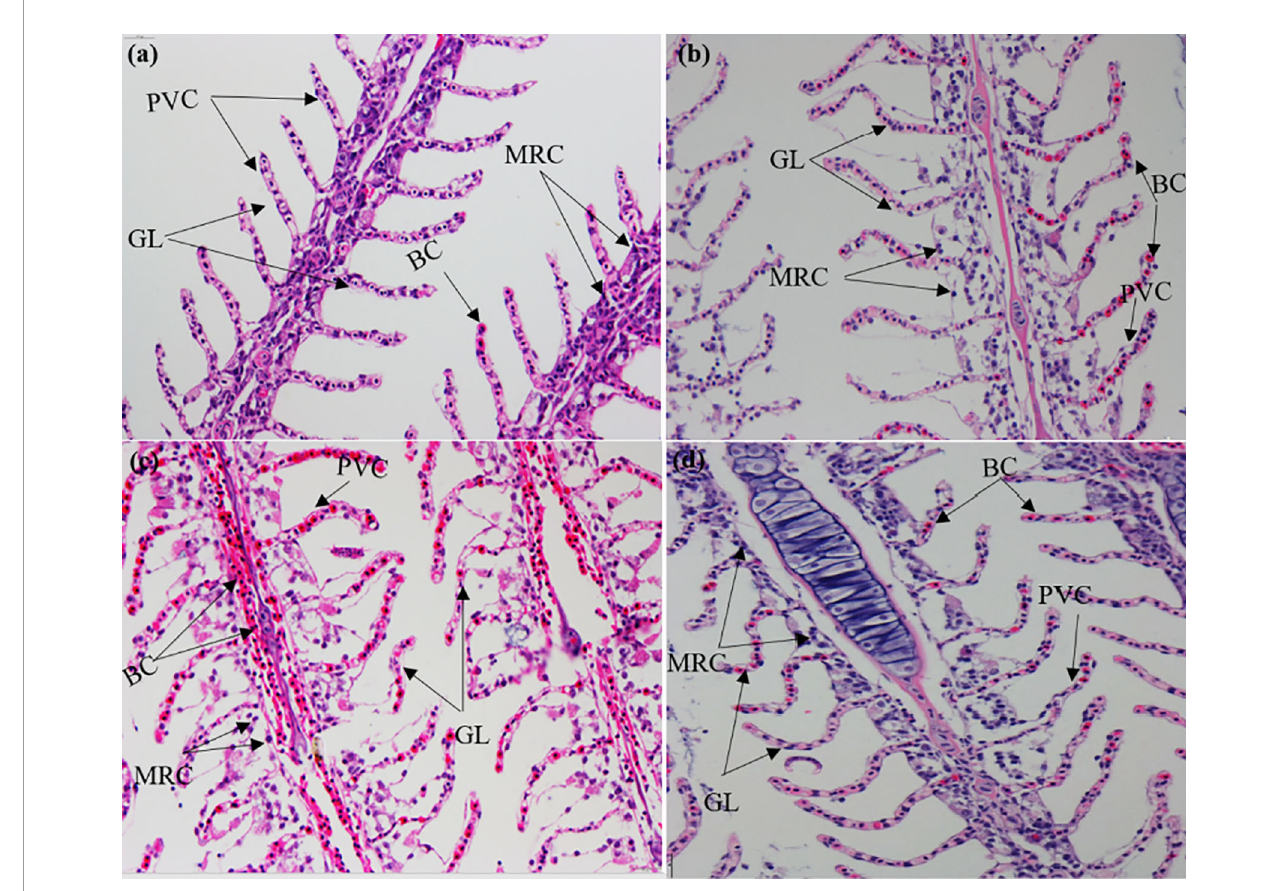
FIGURE 1 | Hematoxylin and eosin (H&E) staining of gill sections under (A) normoxia; (B) hypoxia; (C) demi-asphyxia; and (D) asphyxia stress in silver carp. GL, branch leaf; BC, blood cells; PVC, pavement cells; MRC, mitochondria-rich